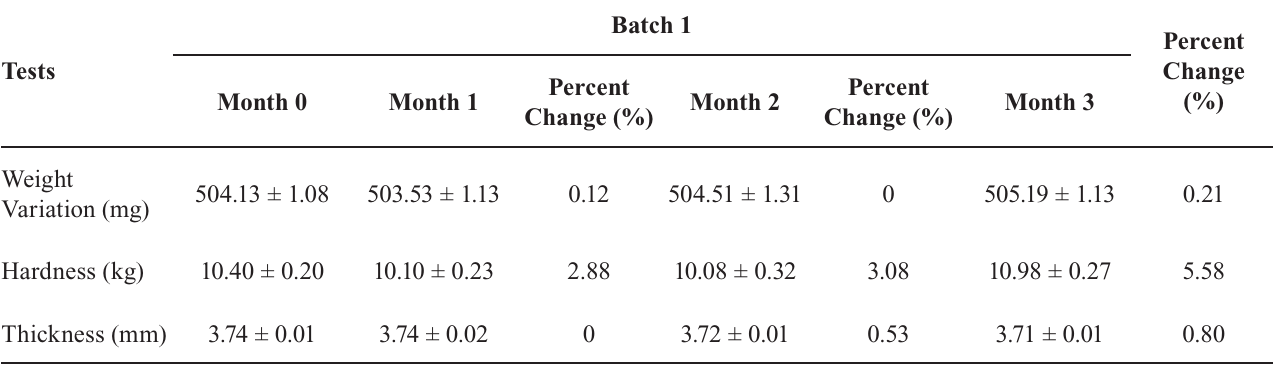
TABLE V - S ummary of the results for batch 1: formulated mucoadhesive mefenamic acid buccal